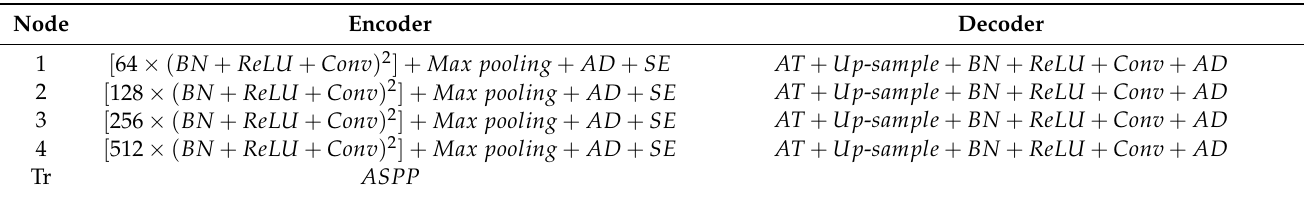
Table 1. The architecture of